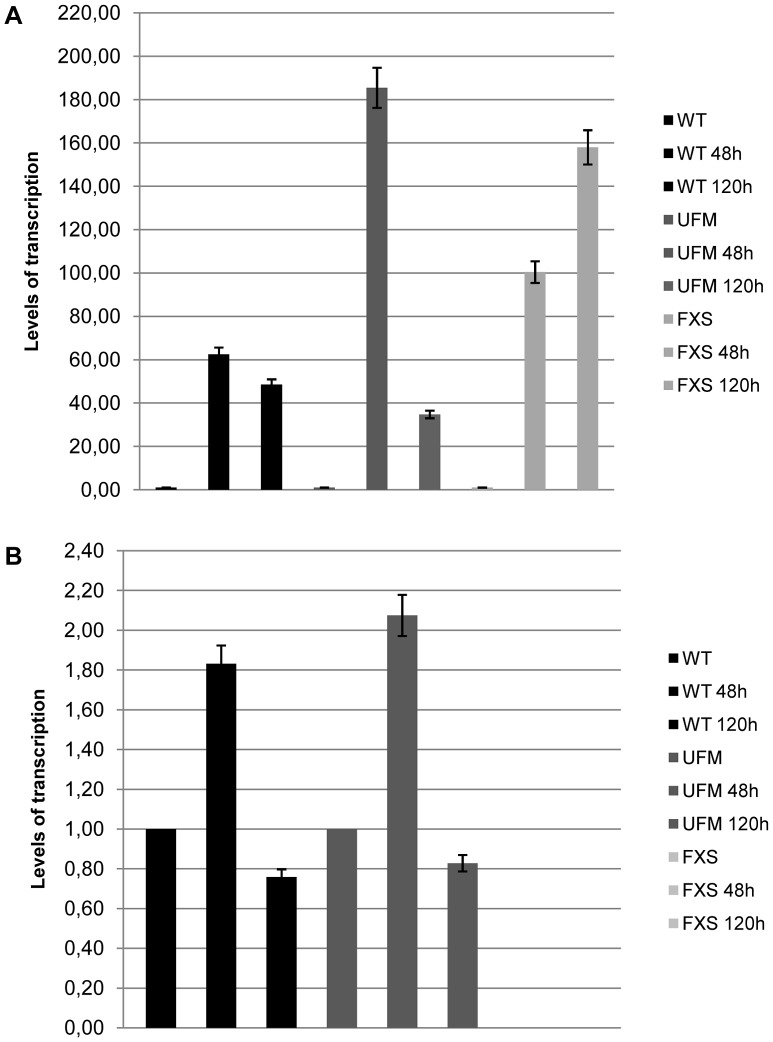
CTCF overexpression in WT, UFM and FXS fibroblasts.
CTCF overexpression in WT, UFM and FXS cell lines after transfection with a commercial vector containing the open reading frame of variant 1 of CTCF. Quantitative RT-PCR showed a strong increase of CTCF mRNA after 48 and 120 hours from transfection (A), while levels of FMR1 transcription remained substantially unchanged (B). The levels of CTCF transcription in the untreated cells were arbitrarily set at 1 as well as those of FMR1 transcript in WT and UFM fibroblasts, while those of FMR1-mRNA in FXS cells were set at 0. Bars indicate standard deviation.